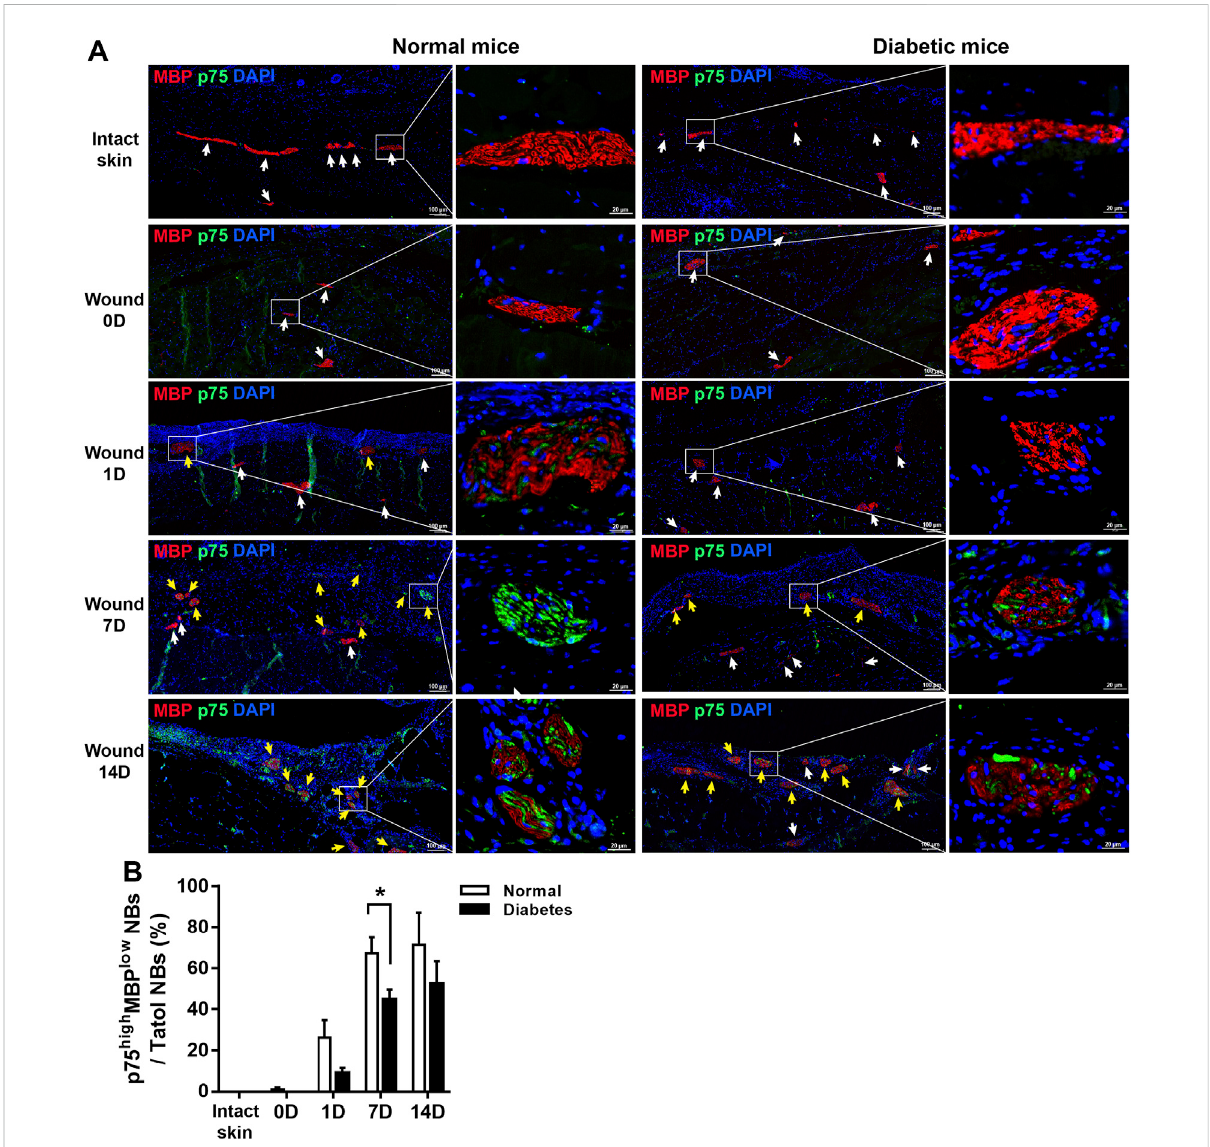
FIGURE 4 Diabetic SCs display delayed de-differentiation during cutaneous wound healing. (A) Representative immuno fl uorescence analyses of p75 (green) and MBP (red) in normal and diabetic mice in intact skin and in the wound bed at days 0, 1, 7, and 14 post-wounding. The white arrows represent the NBs displayed barely expression of p75 and high levels of MBP, the yellow arrows show the NBs displayed high levels of p75 and low levelsofMBP. (B) Quanti fi cationofthepercentageofp75 high MBP low NBsrelativetototalNBsinnormalanddiabeticmiceinintactskinandinthe wound bed at days 0, 1, 7, and 14 post-wounding. Data are presented as mean ± SD, * p < .05, n = 6/group, two-way ANOVA, Bonferroni ’ s post hoc